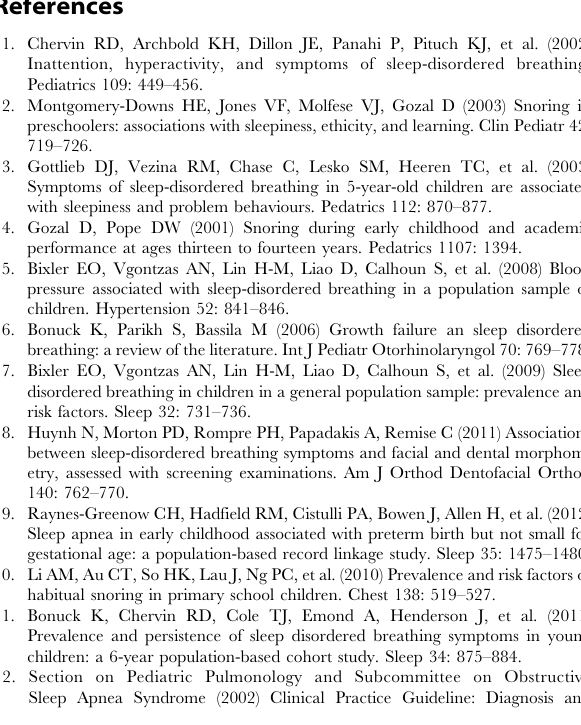
Figure S1 Directed Acyclic Graph for assessing the Causal association between Breastfeeding and Snoring. green circle= exposure blue circle = outcome blue oval = ancestor of outcome . grey oval= unobserved (latent) pink oval = ancestor of exposure and outcome . green line = causal path pink line= biasing